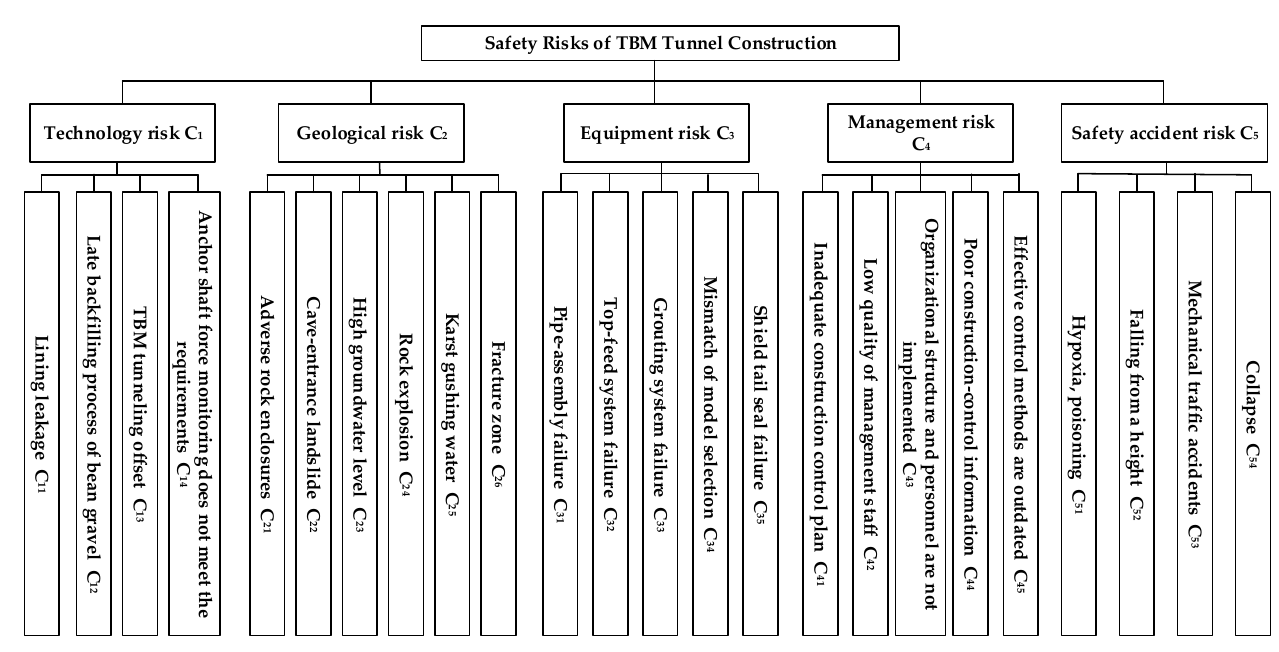
Figure 1. Safety risks of TBM tunnel construction.